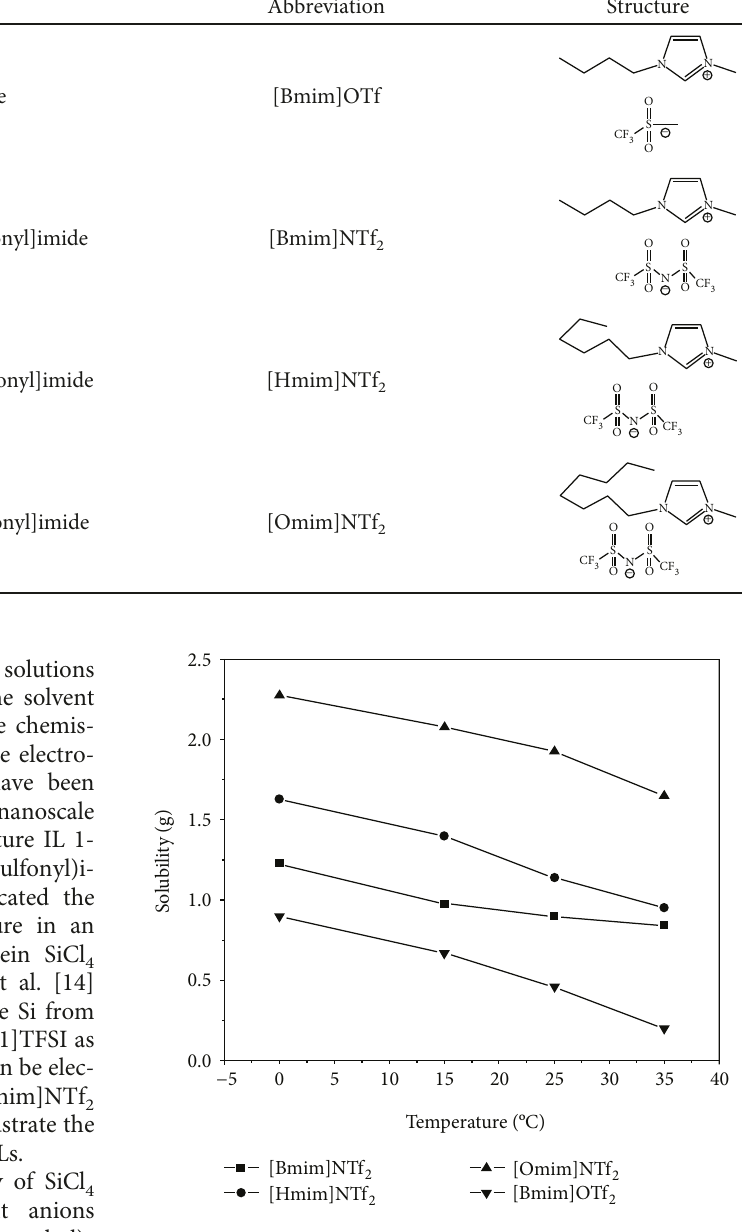
in the imidazolium ILs at di ff erent 4